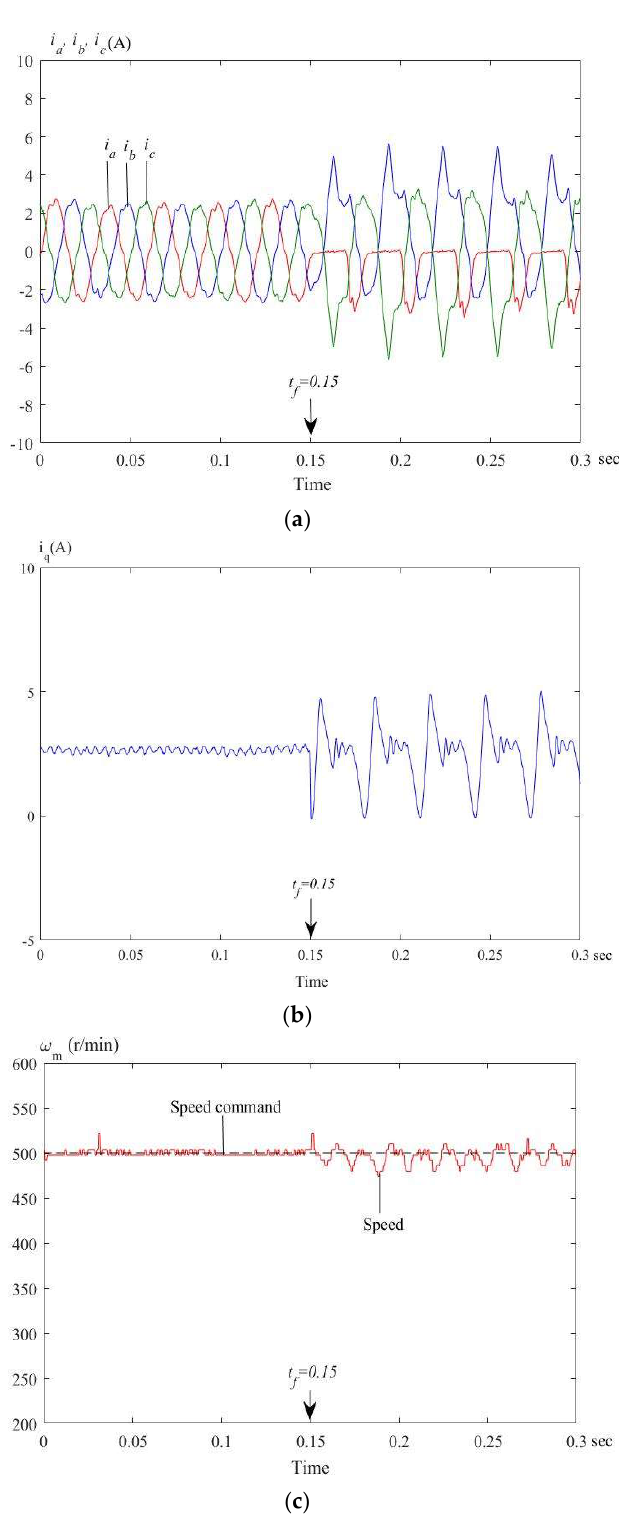
Figure 13. Measured results of the a -phase open-circuited without using the fault-tolerant method: ( a ) three-phase currents; ( b ) q -axis current; ( c ) speed.